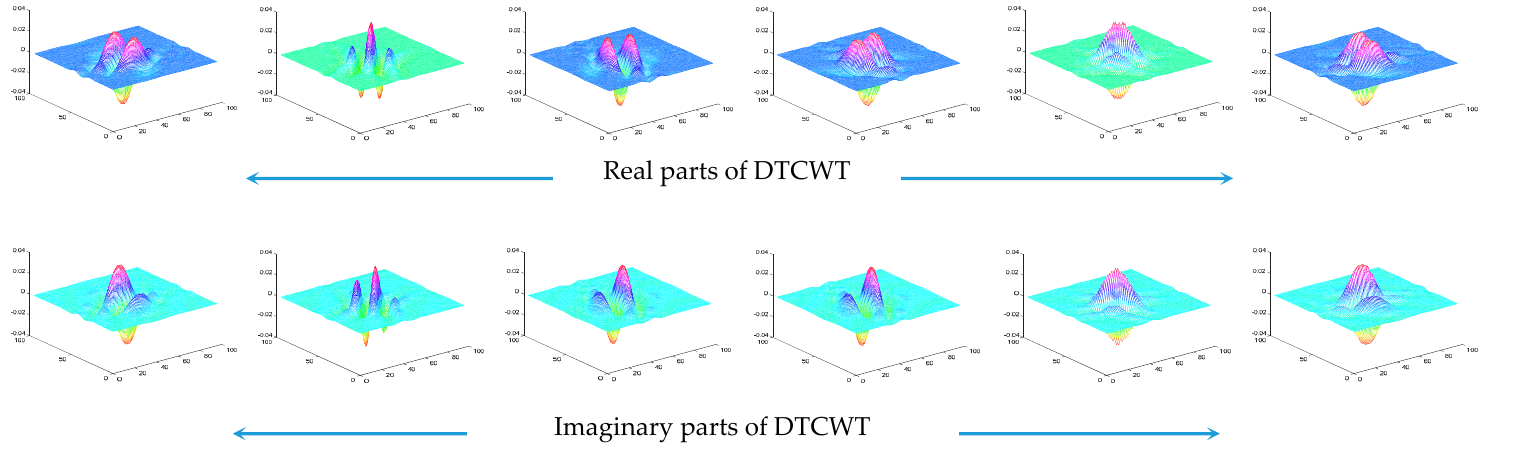
Figure 6. Impulse responses on the 2D complex wavelets at level 4.